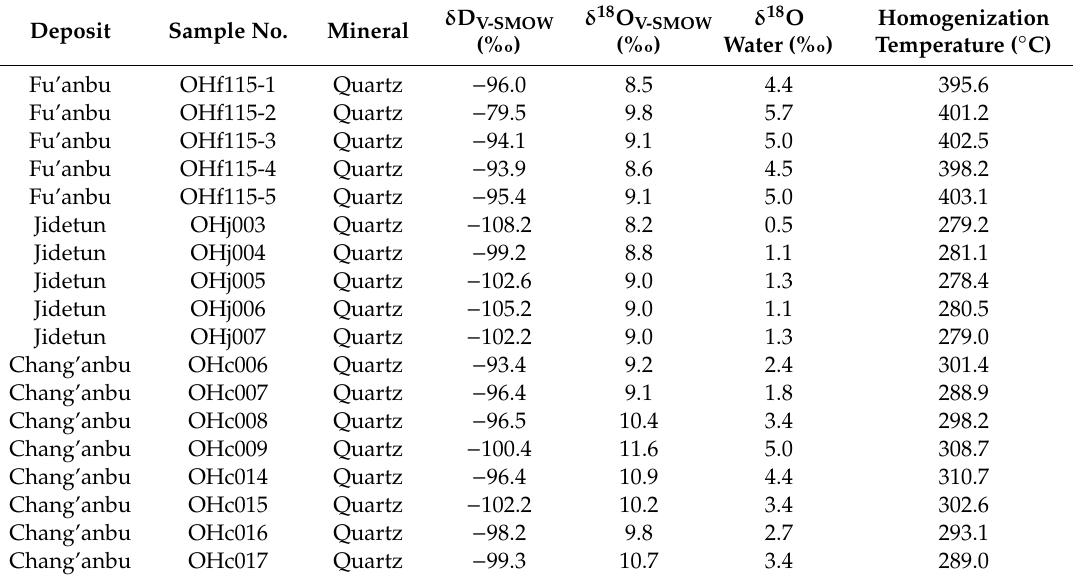
Table 3. H and O isotopic composition of quartz from molybdenite-quartz veins of the Chang’anbu, Fu’anbu and Jidetun ore deposits.